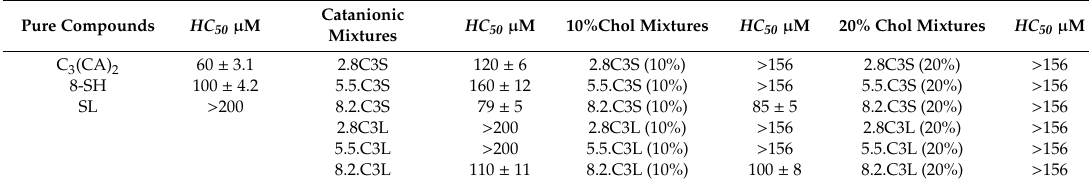
Table 5. HC 50 values of pure surfactants and their catanionic mixtures.